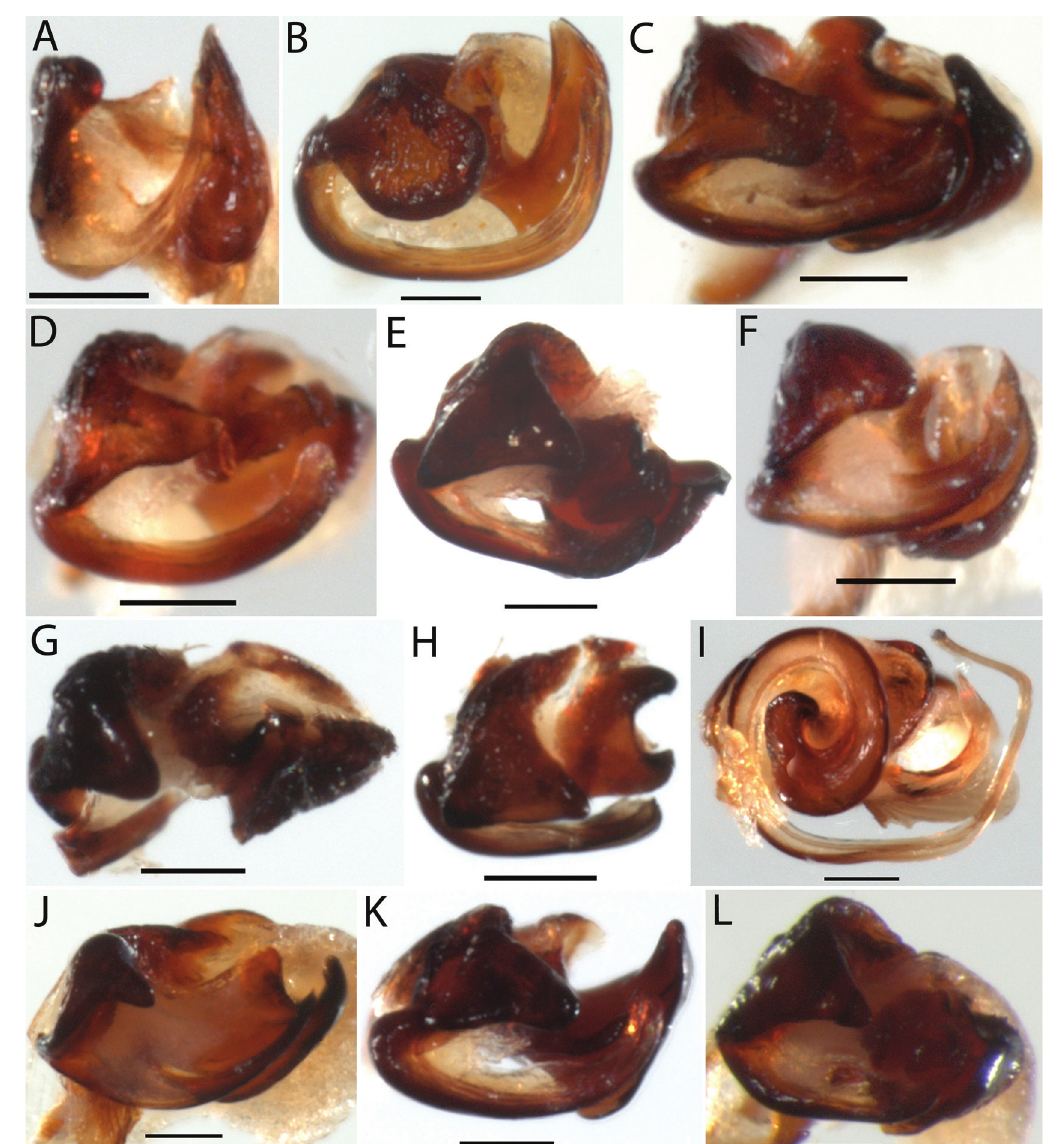
Figure 47. Artoria spp., palea of male pedipalp, ventral view: A , A. barringtonensis sp. n. (AM KS122794); B , A. be- aury sp. n. (AM KS127757); C , A. belfordensis sp. n. (AM KS127759); D , A. bondi sp. n. (AM KS128073); E , A. booderee sp. n. (AM KS128069); F , A. comleroi sp. n. (AM KS128078); G , A. corowa sp. n. (AM KS128079); H , A. equipalus sp. n. (AM KS1228077) I , A. extraordinaria sp. n. (AM KS128074); J , A. grahammilledgei sp. n. (AM KS127756); K , A. helensmithae sp. n. (AM KS128076); L , A. kanangra sp. n. (AM KS45008). Scale bars: 0.1 45A). Venter pale with darker pattern around spinnerets Eyes . Diameter of AME: 0.09; ALE: 0.07; PME: 0.30; (Fig. 45B); spinnerets dark grey. PLE: 0.22. Pedipalps . Tibia as long as broad; cymbium tip with Anterior eye row. Straight, evenly spaced. 4–5 macrosetae (Fig. 45E, F); dorsal scopula patch present; Chelicerae. Dark brown. tegular apophysis small, distally scooped, with tiny tooth, basally narrowed to 1/2, tip rounded not reaching margin of cymbium (Fig. 45E, F); palea as long as wide; baso- embolic apophysis triangular with rounded tip; embolus semicircular; terminal apophysis tip triangular (Fig. 48I). Female (based on paratype AM KS63496). Total length 5.1. Prosoma. Length 2.6, width 1.8; carapace and sternum colouration as male (Fig. 45C, D).